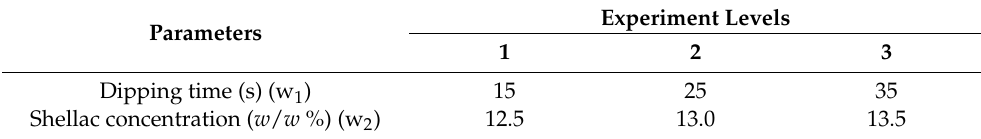
Table 2. Levels of parameters.